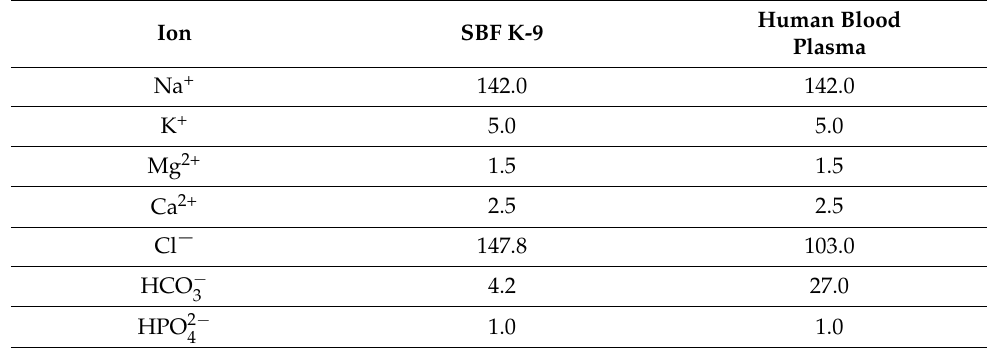
Table 2. Ionic concentrations (mM) of SBF K-9 and human blood